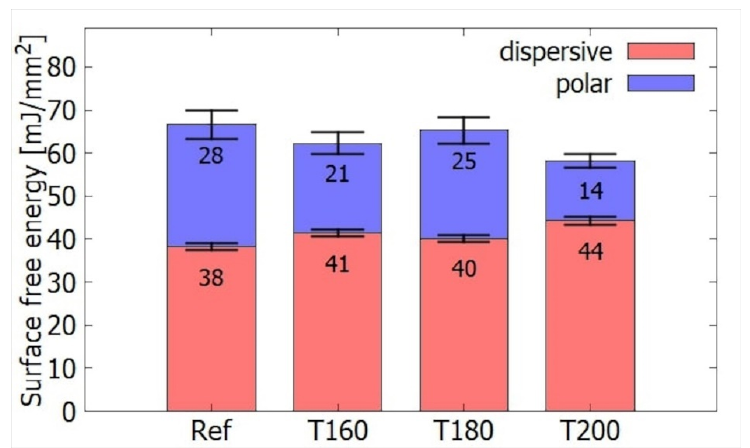
Figure 3. Comparison of the surface energy of different TMW without plasma treatment.